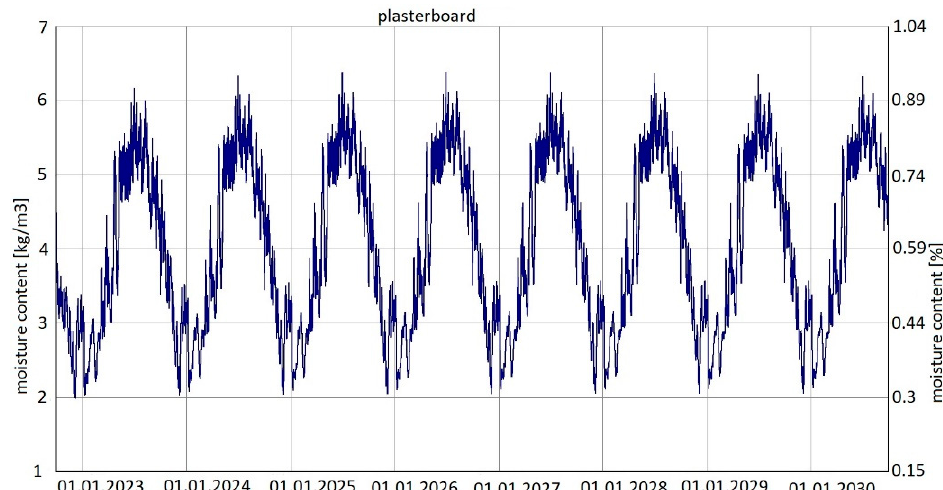
Figure 15. Changes in moisture content in glass mineral wool over eight years, variant 5 [70].